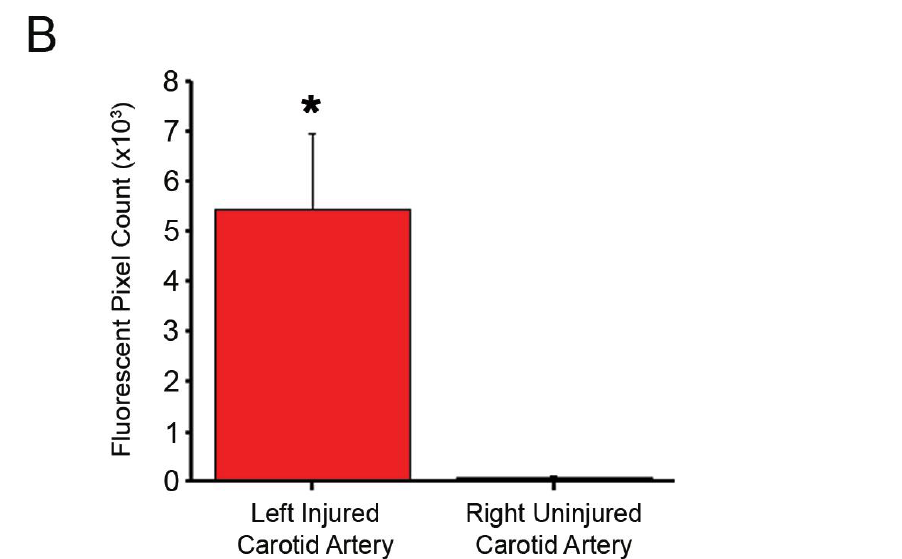
Figure 1. Immunofluorescent staining of fractalkine is present in left injured carotid artery with no fluorescent staining in the control uninjured right carotid artery. ( A ) Fluorescent microscopy of left injured and right uninjured carotid artery stained for CX3CL1. Green = autofluorescence of arterial lamina and red = CX3CL1 staining. Magnification, 20 × ; n = 3 / treatment group; scale bar = 100 µ m. ( B ) Quantification of fluorescence demonstrates the elevated expression of fractalkine in the injured artery compared to control uninjured artery, * p < 0.05.